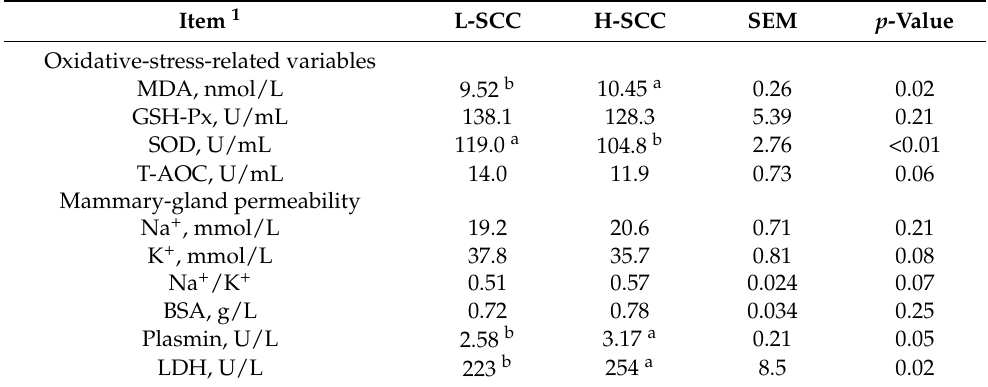
Table 4. Milk variables related to oxidative stress status and tight junction integrity of mammary gland of high-yielding dairy cows with different somatic cell counts